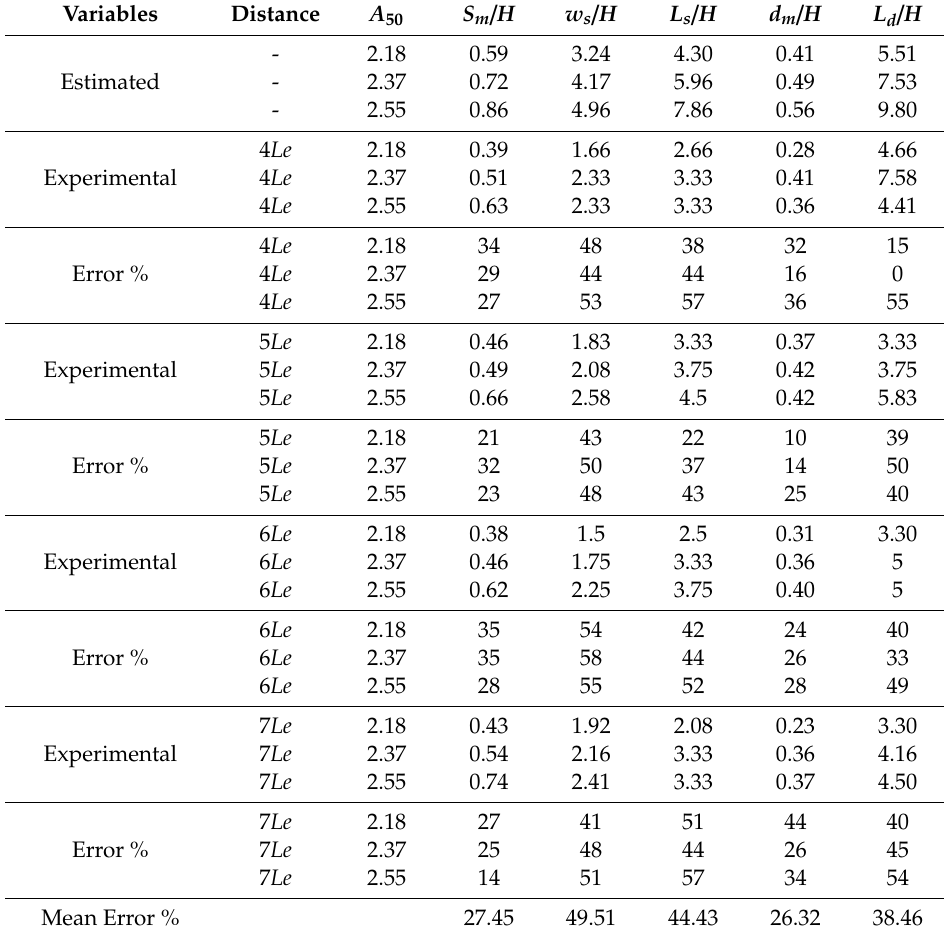
Table 2. Comparison between experimental and estimated parameters by equations 1 to 5 around the first EPG.